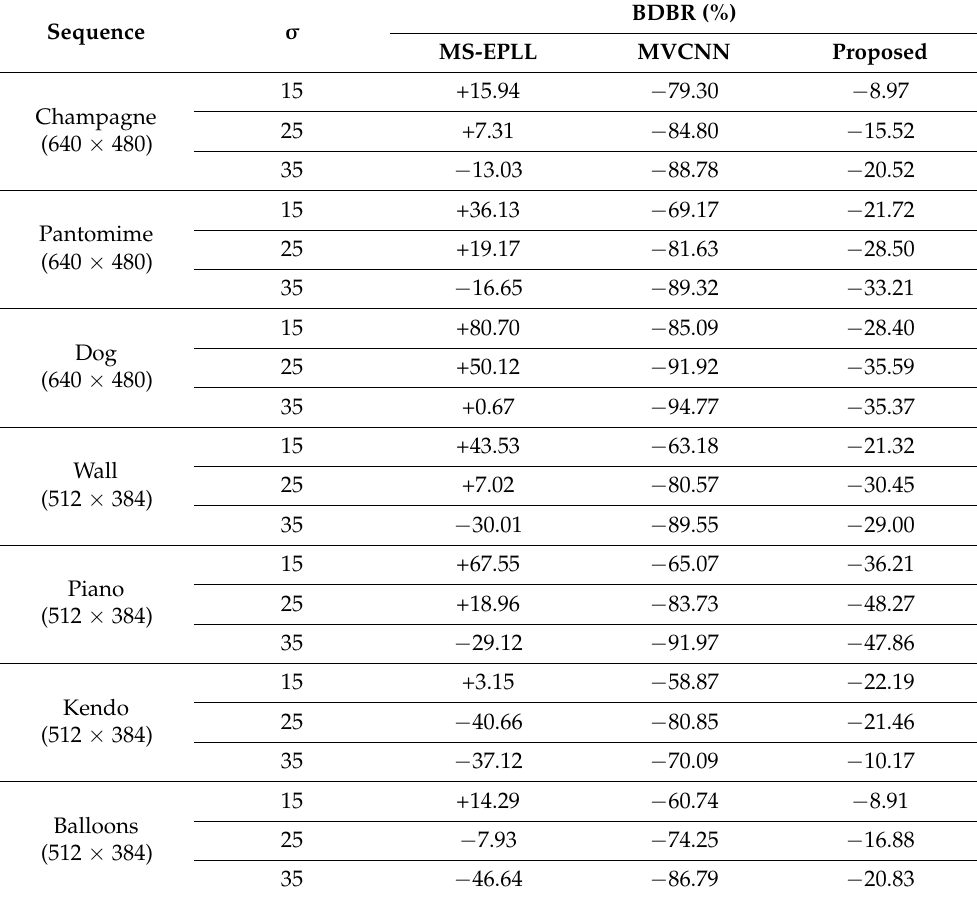
Table 5. Comparison of compression efficiency for noisy multi-views (low